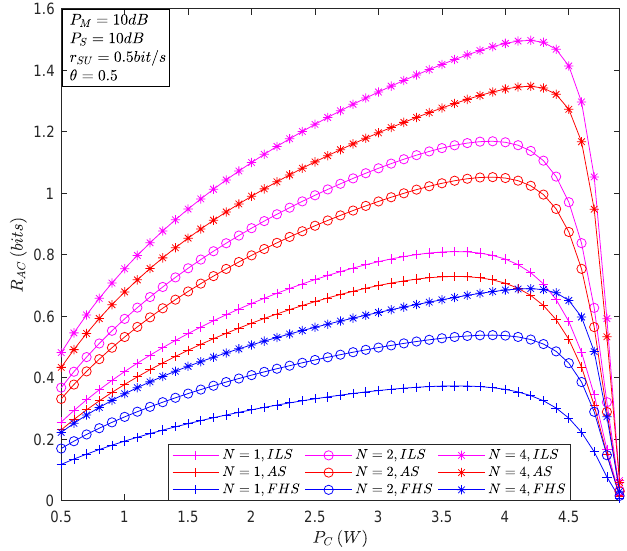
Figure 4. The ACR versus P C for the different number of